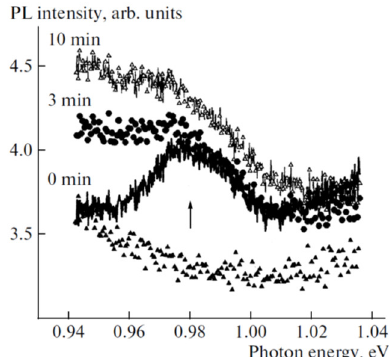
Figure 30. Spectra of the photoluminescence of por-Si powder in vacuum (lowest curve) and in oxygen atmosphere at P ox =1 bar for different times after illumination (indicated near the corresponding curves). E exc = 2.33 eV, I exc = 0.1 W/cm 2 , T = 300 K. (Reprinted from Reference [73] by curves). E exc = 2.33 eV, I exc = 0.1 W / cm 2 , T = 300 K. (Reprinted from Reference [73] by permission from permission from Springer Nature Customer Service Centre GmbH: Springer © 2010).